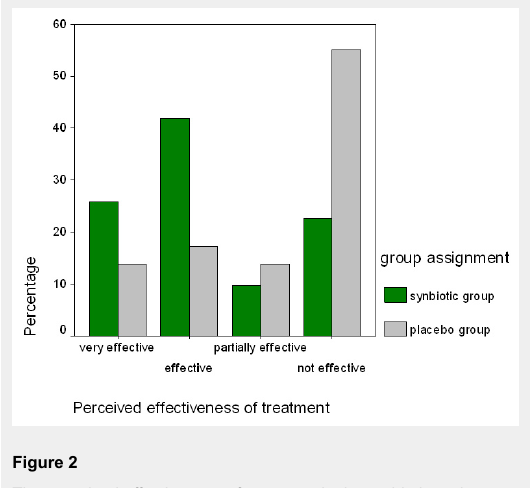
The perceived effectiveness of treatment in the probiotic and placebo groups after 4 weeks of treatment is shown. A total of 77.4% of the synbiotic group and 44.8% of the placebo group regarded the treatment as “effective” or “partially effective” which was significantly different ( p = 0.03).